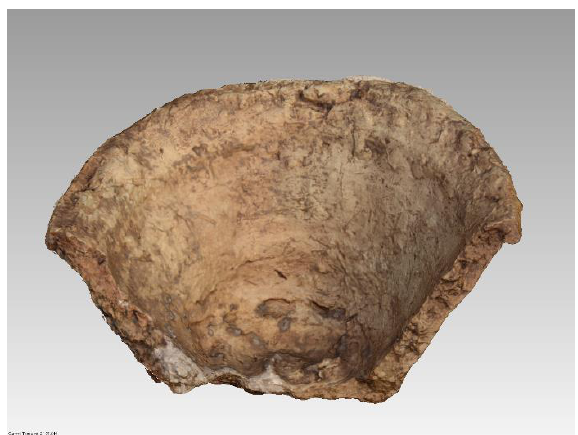
Figure 12. Creation of the final model; 3D model of the original find (the bowl from Qala